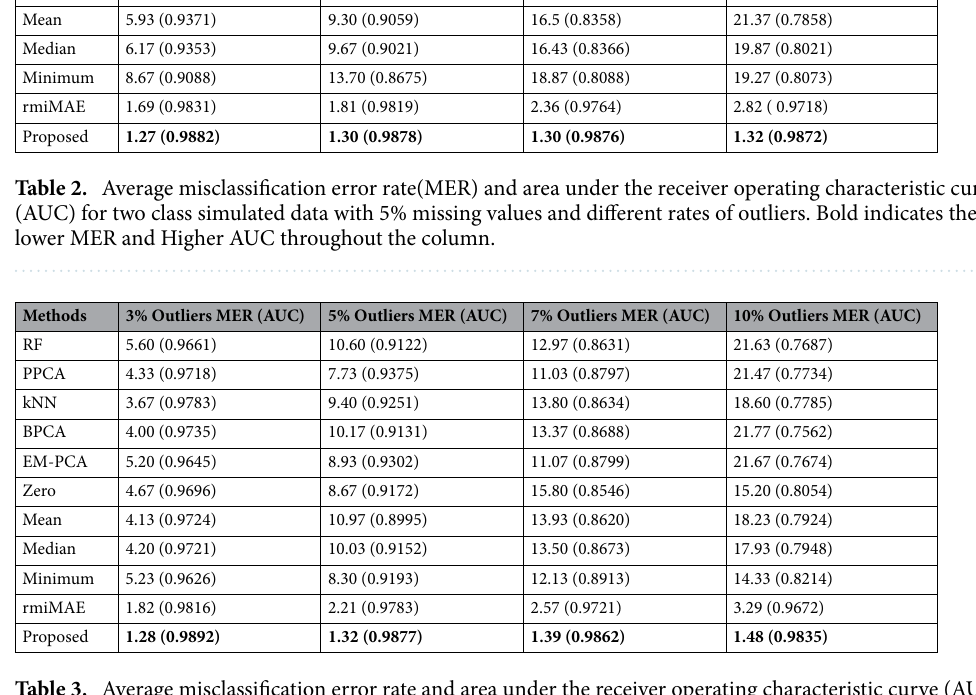
Table 3. Average misclassification error rate and area under the receiver operating characteristic curve (AUC) for three class simulated data with 5% missing values and different rates of outliers. Bold indicates the lower MER and Higher AUC throughout the column.